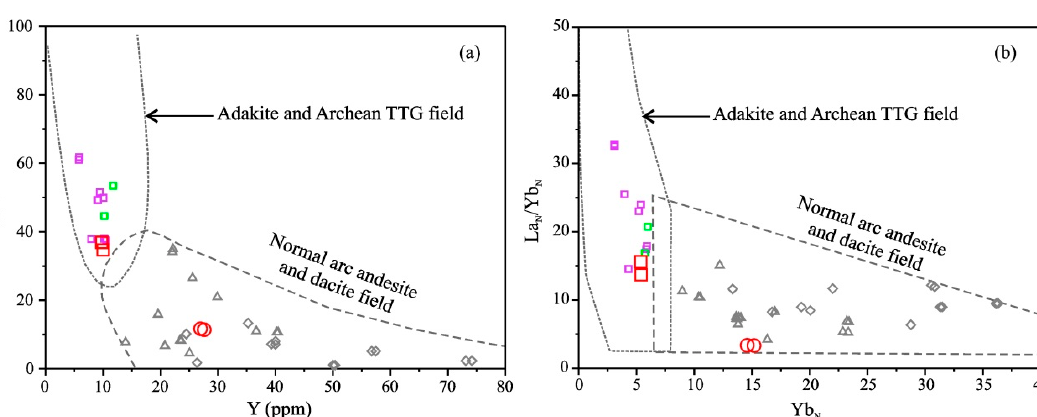
Figure 9. ( a ) Ta versus Yb discrimination diagram [58] for the SCS granodiorites of the present study and Mesozoic arc and adakitic granitoids from the South China Sea [23,24]. The symbols are as in